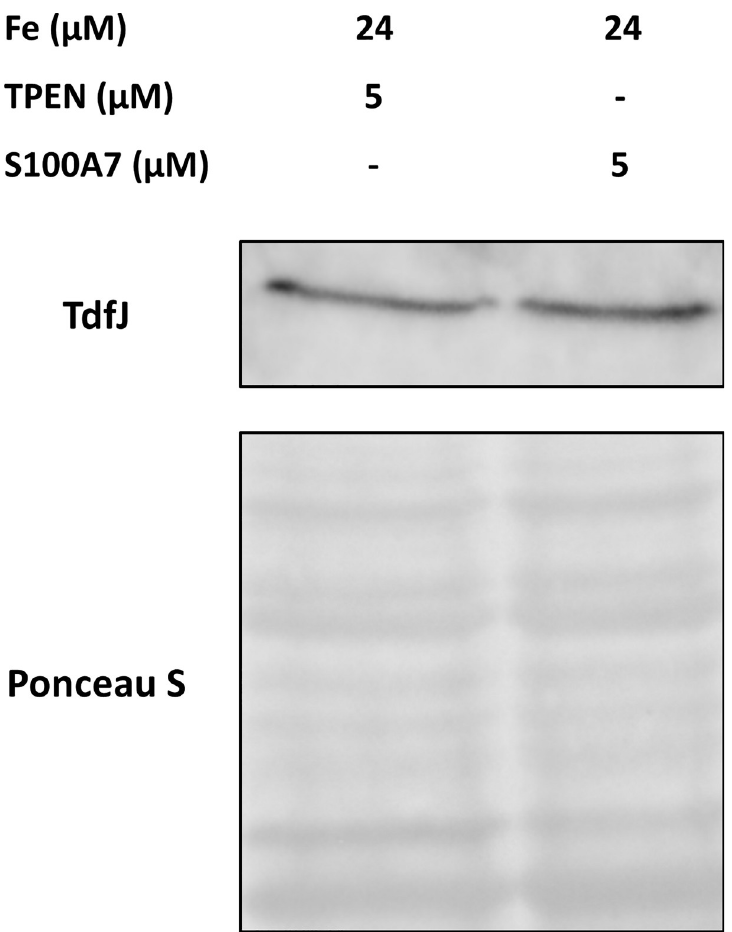
indicated. These cultures were grown for 6 hours before whole-cell lysates of equalized density were prepared and subjected to SDS-PAGE and western blotting to detect TdfJ. Equal protein loading is demonstrated by Ponceau staining. N = 3